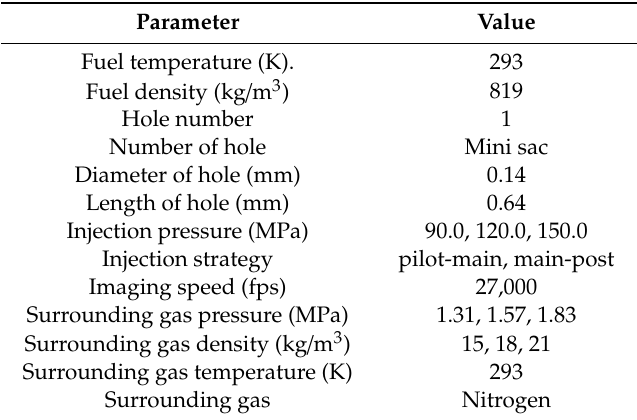
Table 2. Conditions for the fuel spray.